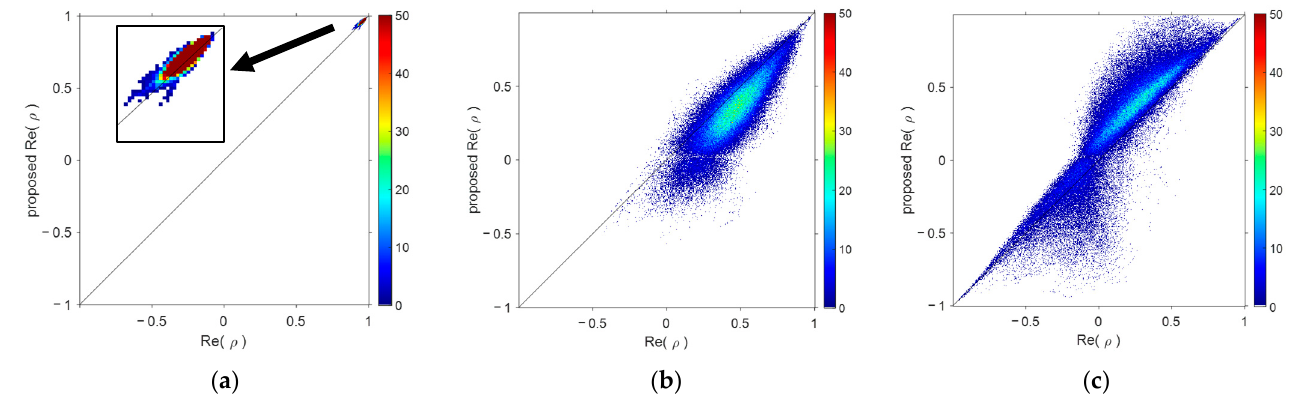
Figure 2. The comparison between the real part of the original ρ and proposed ρ value. ( a ) Ocean area. ( b ) Mountain area. ( c ) Urban area.